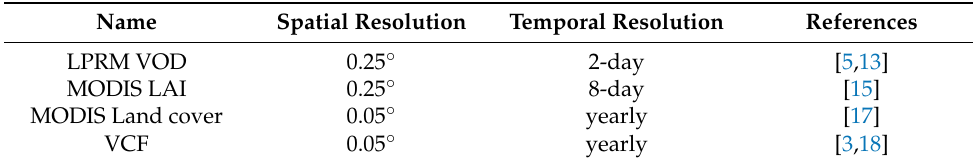
Table 1. Summary of the data used in this